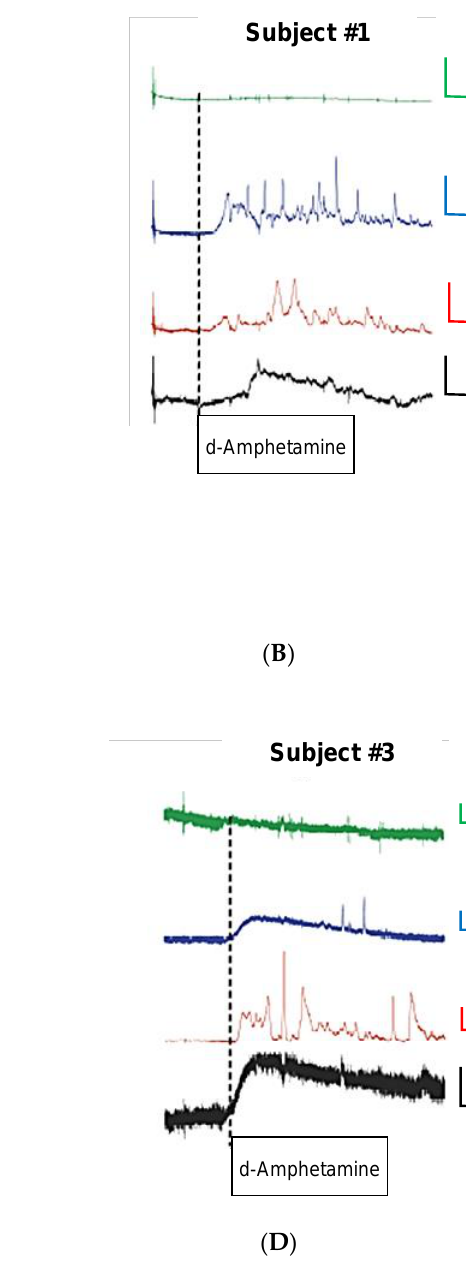
Figure 4. Conformal MEA design for simultaneous measures of in vivo DA dynamics at multiple recording depths. ( A ) Depth profile illustrating location of each MEA pair; ( B – D ) concentration versus time plots for subjects 1–3 before and after administration of d-amphetamine (2 mg / kg, i.p.). Time axis bars are 10 min and concentration axis bars are 100 μM.